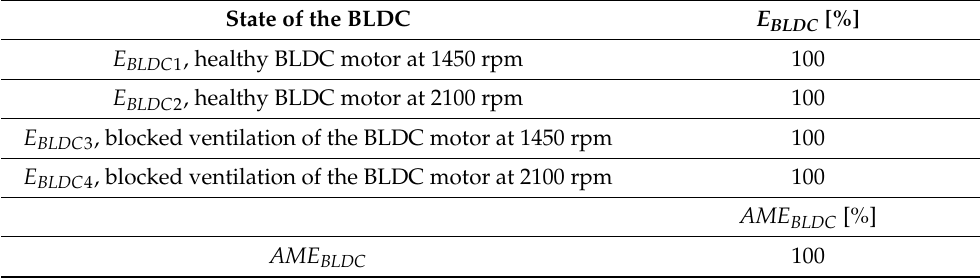
Table 3. Results of recognition for CPoAMoTI method (parameter p = 0–0.9) for the BLDC motor (fan).